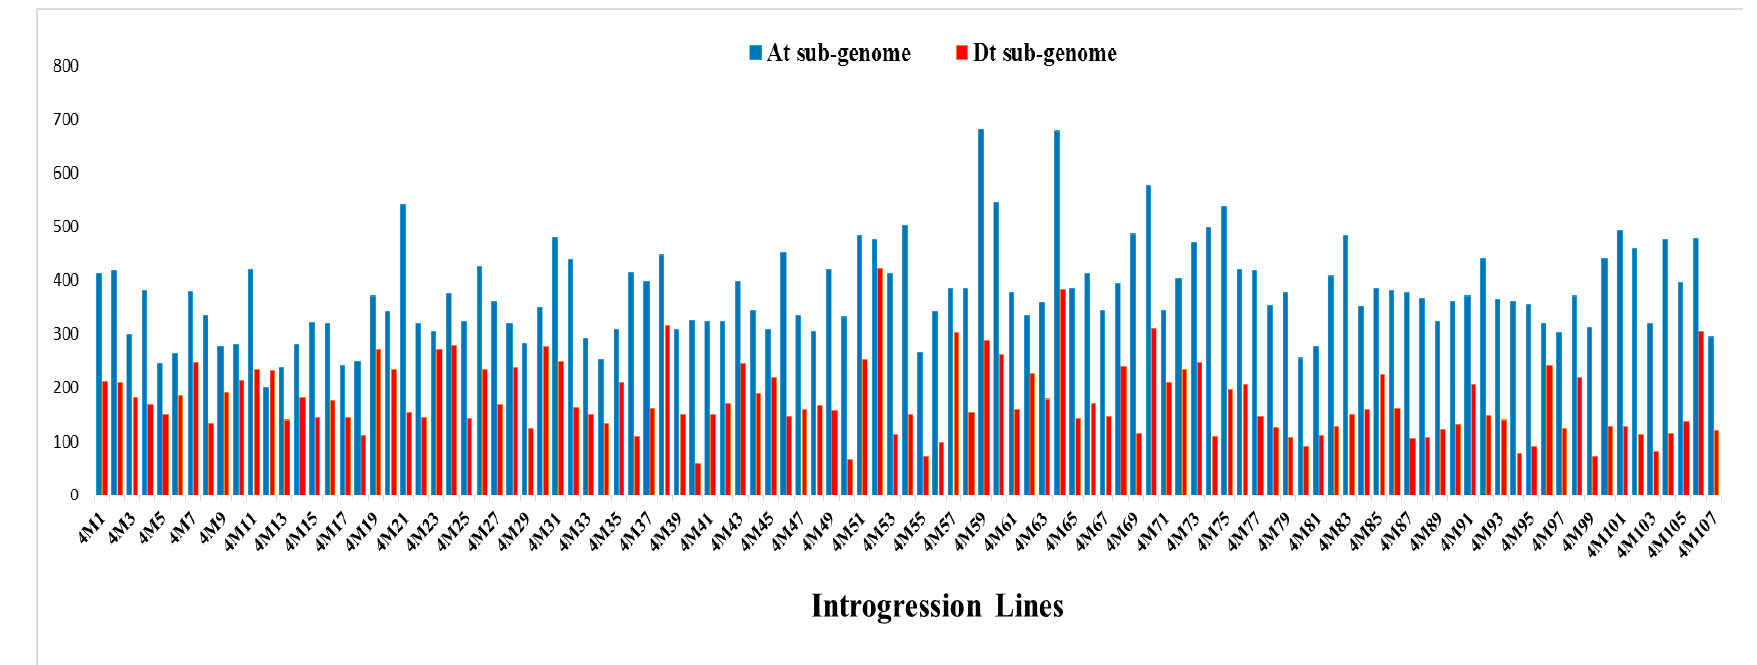
Figure 5. Introgression length in the individual IL population in the At and Dt.